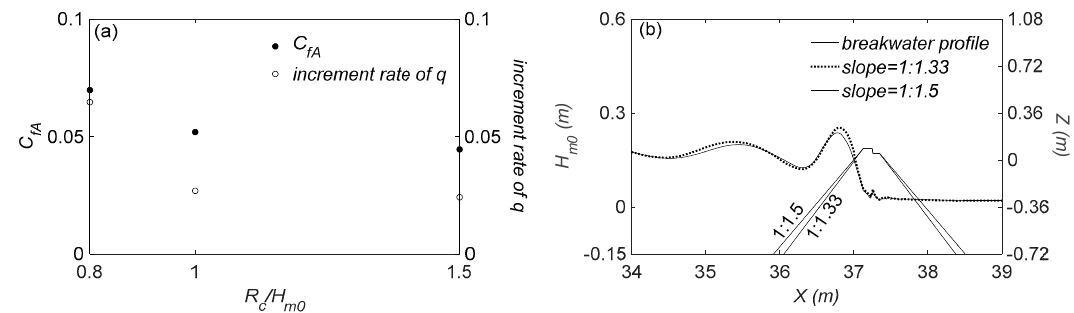
Figure 6. Relationship between C fA and increment rate of q of 1.33 slope relative to that of the 1.5 slope under R c / H m 0 varied from 0.8 to 1.5 ( a ), and the spatial evolution of H m 0 under 1.33 and 1.5 slope ( b ) ( S op is 0.04).